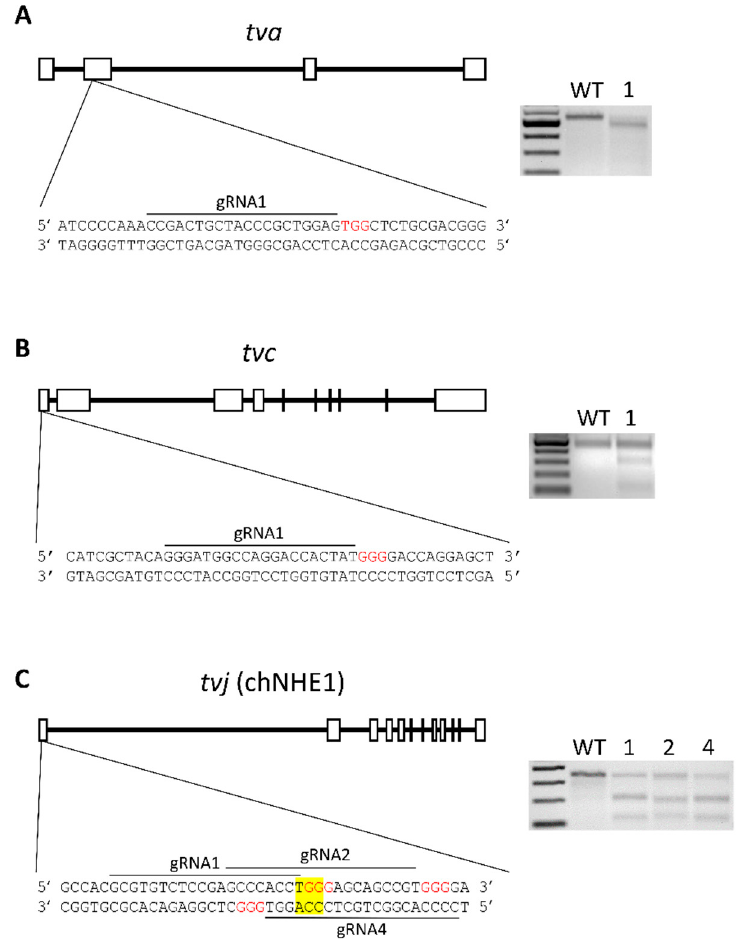
Figure 1. Design of gRNAs of gene editing CRISPR/Cas9 constructs for chicken avian leukosis virus (ALV) receptor genes tva ( A ), tvc ( B ), and tvj ( C ) and their indel generation activity in DF-1 cells. Exon-intron gene structures, the gRNA complementary sequences (underlined), and protospacer adjacent motifs (red) are shown in the left part. TGG trinucleotide coding for the critical W38 of chNHE1 is highlighted in yellow. Results of the T7EI assay for each of the CRISPR/Cas9 constructs are shown as agarose electrophoresis controlled by markers of molecular size and wild-type DF-1 cells (right). Table 1. Oligonucleotides used in this study.